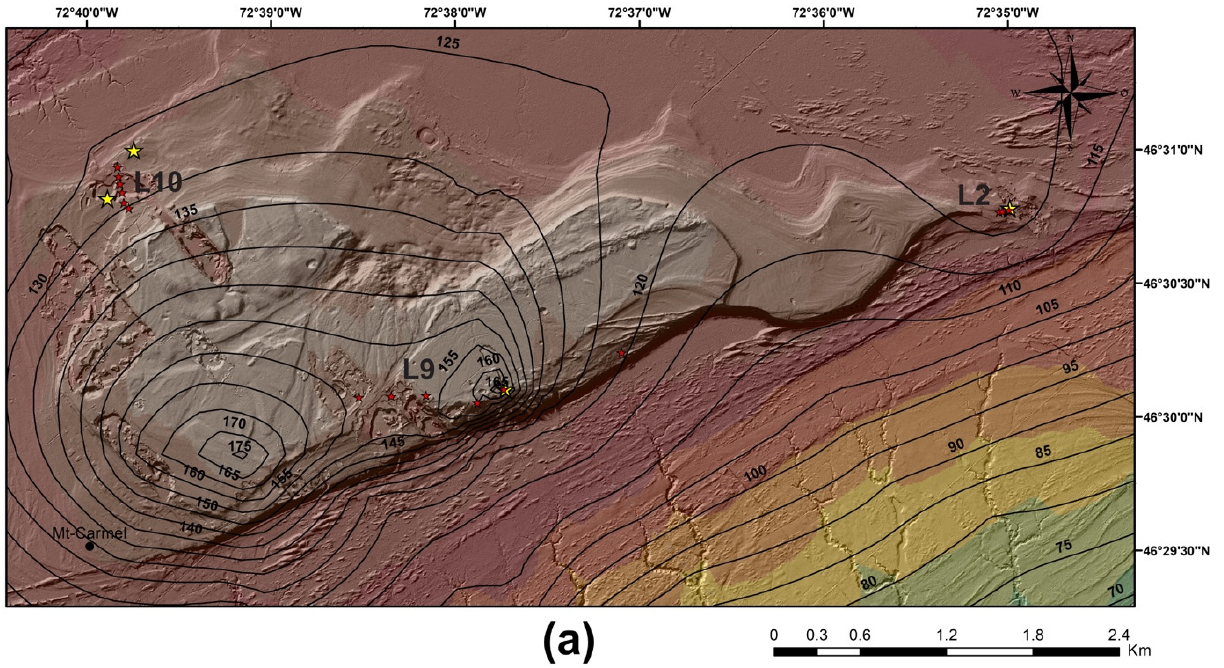
Figure 5. ( a ) Interpolated water table elevation and regional piezometry of the eastern Saint-Narcisse moraine near Notre- Dame-du-Mont-Carmel in Mauricie, Quebec; ( b ) interpolated water table elevation and regional piezometry of the central Saint-Narcisse moraine near Ste-Geneviève-de-Batiscan and St-Narcisse in Mauricie, Quebec. The water table elevations are expressed in meters above sea level for both figures.